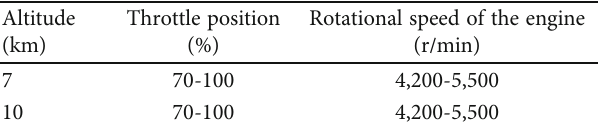
Table 3: Range of operating points corresponding to the selection of sample points.